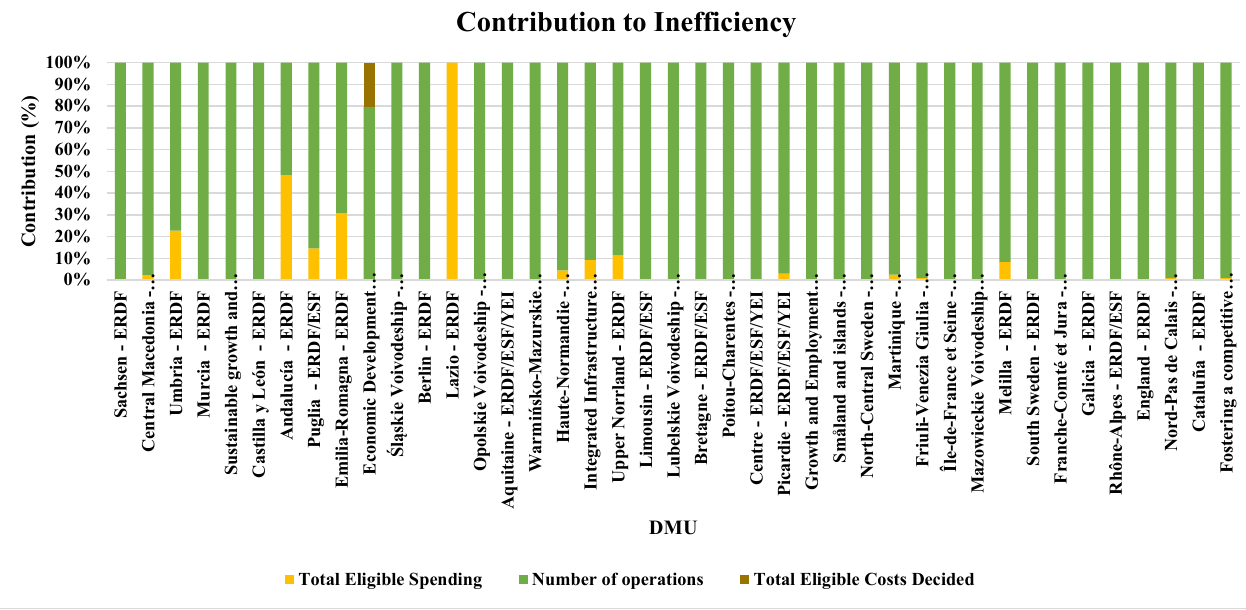
Figure 3. Contribution of inputs and outputs to inefficiency.